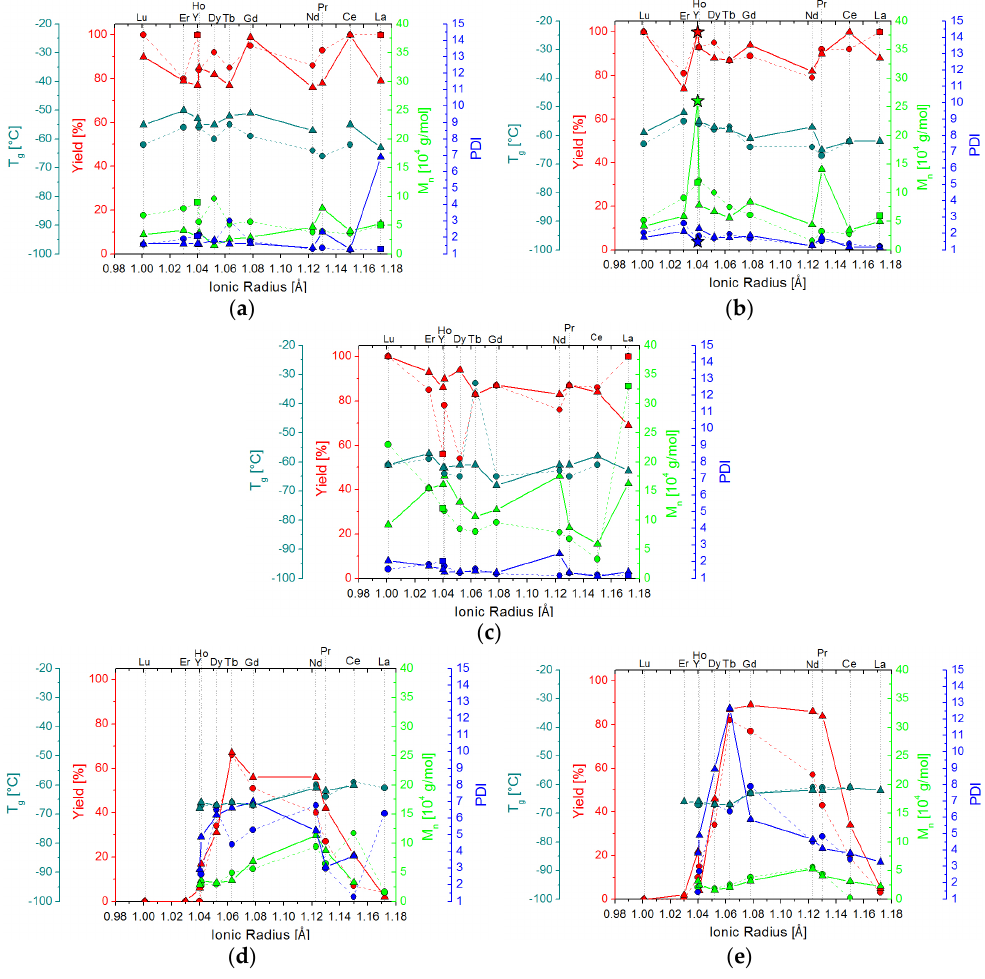
Figure 3. Overview charts representing the chain properties, yield and glass transition temperature of the polyisoprenes obtained from the homoleptic rare ‐ earth metal tetramethylaluminates 2 Ln . Panels ( a – e ) give details on the data obtained from the application of a certain cocatalyst ( A – E; A = [Ph 3 C][B(C 6 F 5 ) 4 ], B = [PhNMe 2 H][B(C 6 F 5 ) 4 ], C = B(C 6 F 5 ) 3 , D = Me 2 AlCl, E = Et 2 AlCl). Results for the addition of 1 equiv. of cocatalyst per aluminate precatalyst after 1 h are shown by circles (dashed lines), 2 equiv. by triangles (solid lines). If such results were not available, data of reaction times of 24 h are shown marked with squares and stars, respectively. The lanthanide precatalysts Ln(AlMe 4 ) 3 ( 2 Ln ) are shown in the order of increasing ionic radii ( x ‐ axis) [28,29]; the corresponding data are shown referring to four different y ‐ axes: red (yield), green ( M n ), blue (PDI) and teal ( T g ). In all panels lines are meant to assist the reader to follow the certain curves within the plot and not to indicate linear behavior of the curves in between the points of measurement. For a more traditional compilation of the polymer data in table form, sorted by precatalyst, see Tables S1.2.1—S1.2.11, Supplementary Materials.